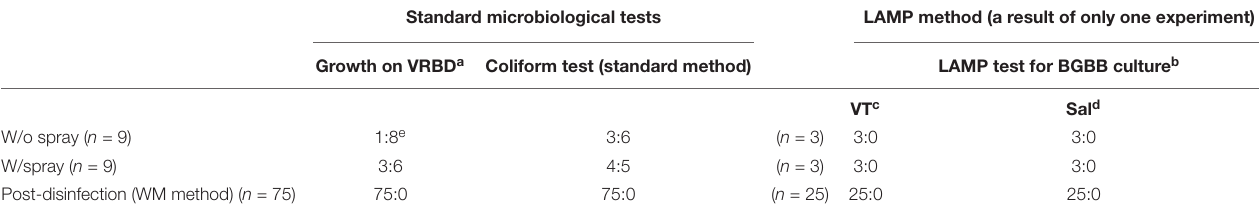
TABLE 7 | The result summary of three experiments of spray method and VV method synergistic effect on the beef without artificial contamination.